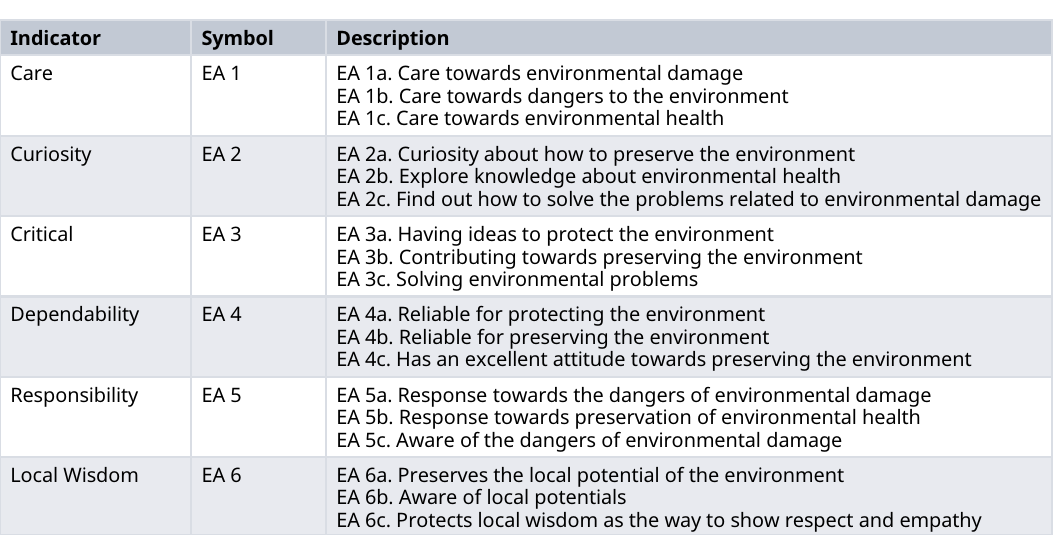
Table 2. Environmental awareness (EA) indicator.